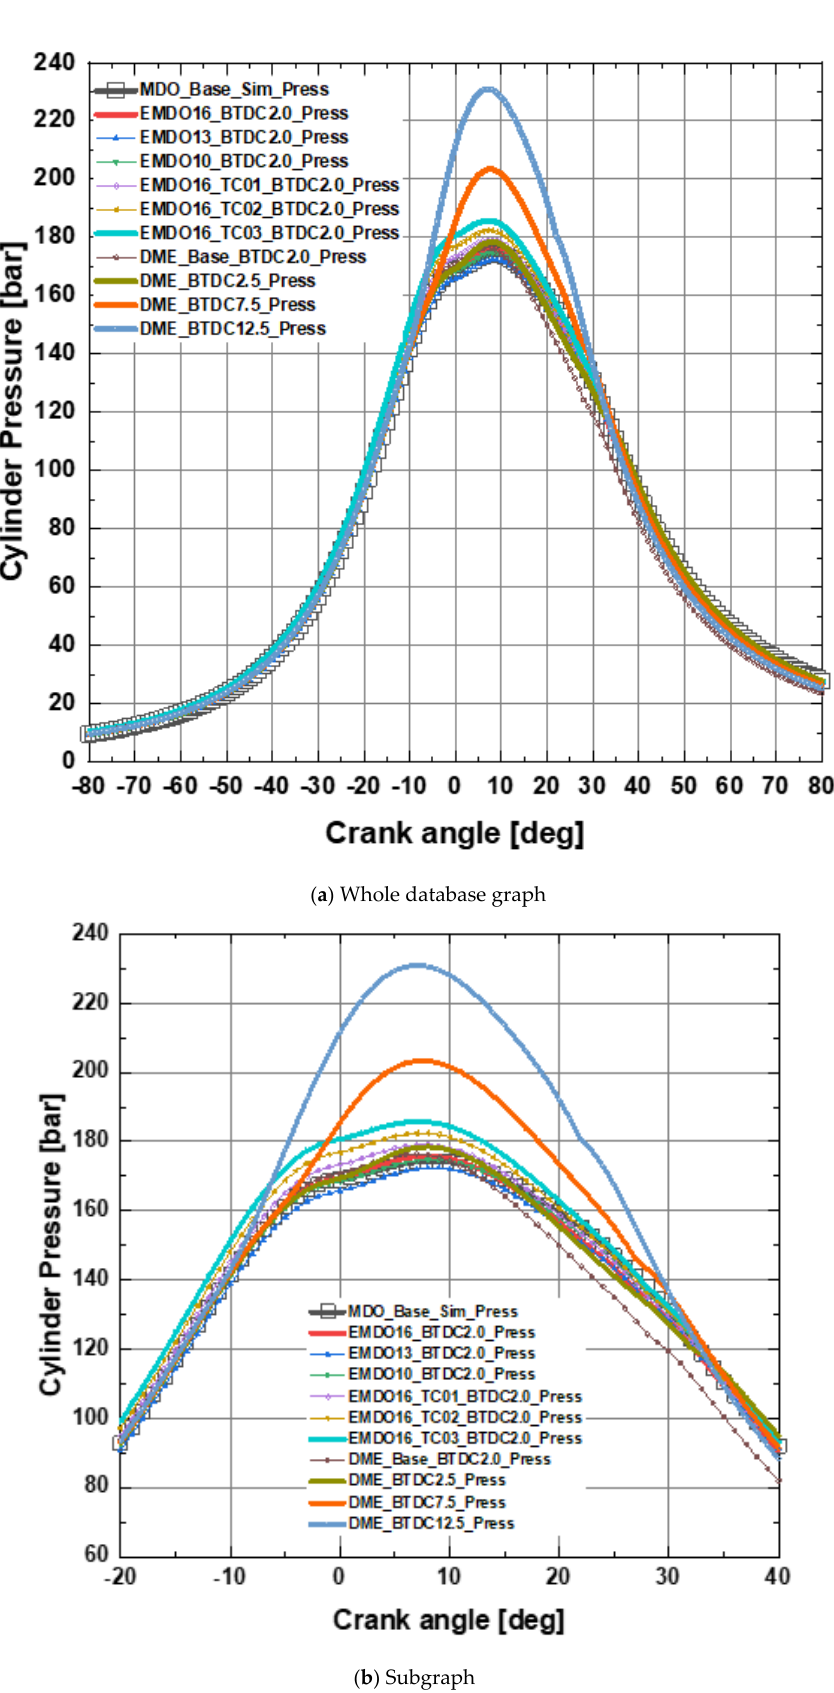
Figure 3. Combustion pressure history of the cylinder in accordance with MDO, EMDO, and DME fuels for 100% engine loads. fuels for 100% engine